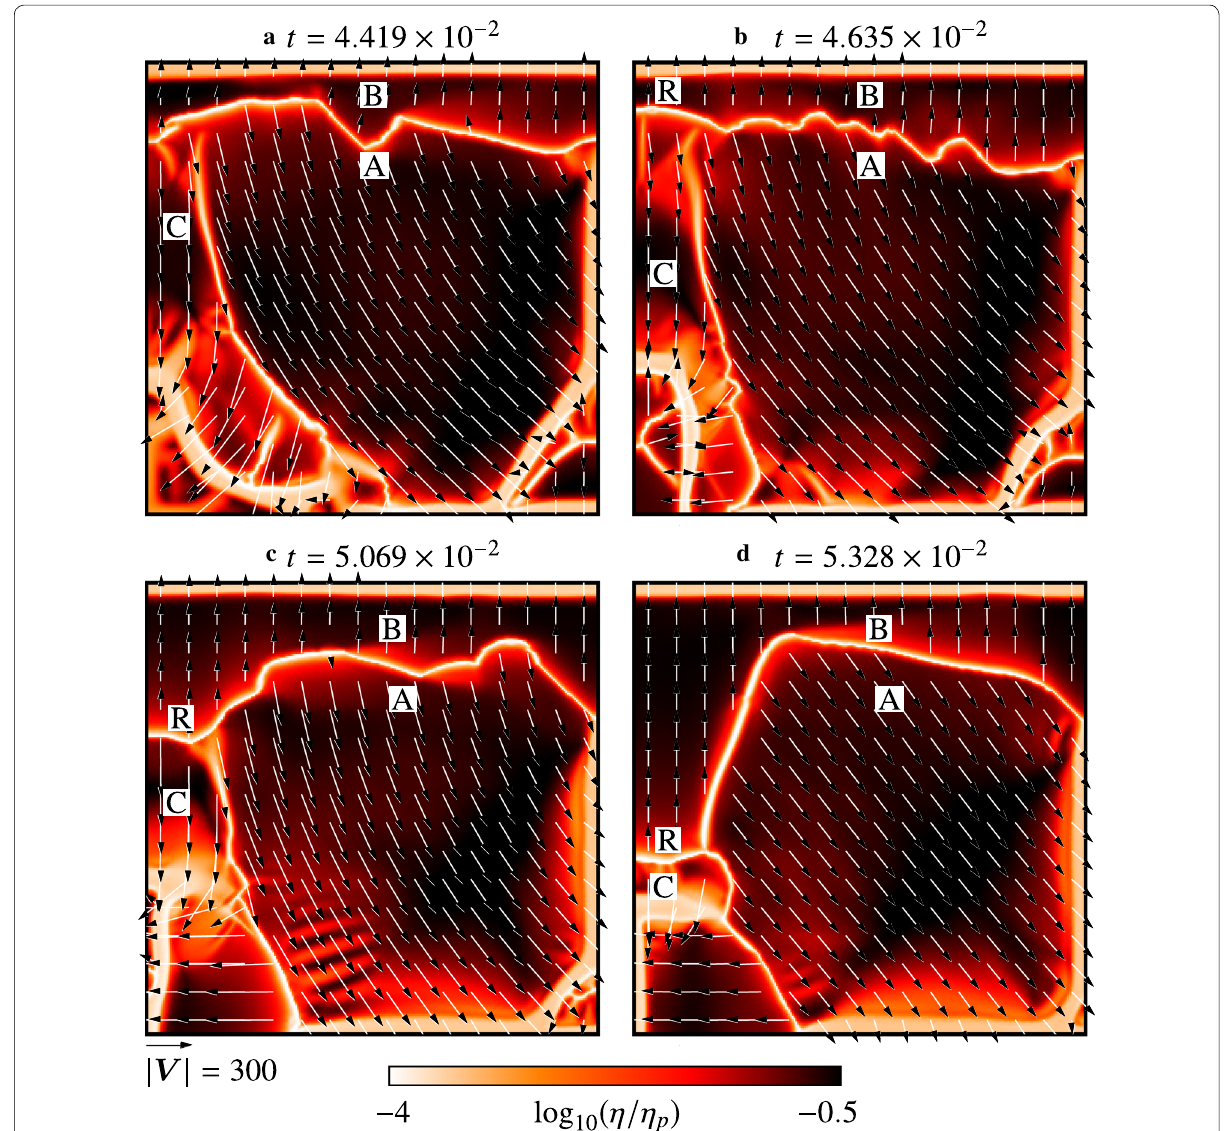
Fig. 3 The time evolution of the surface plate motions. Snapshots of the distributions of viscosity η (colour) and velocity V (arrows) in a horizontal plane along the surface at the elapsed times indicated in the figure. The values of η are normalised by η p , the viscosity of intact material at the